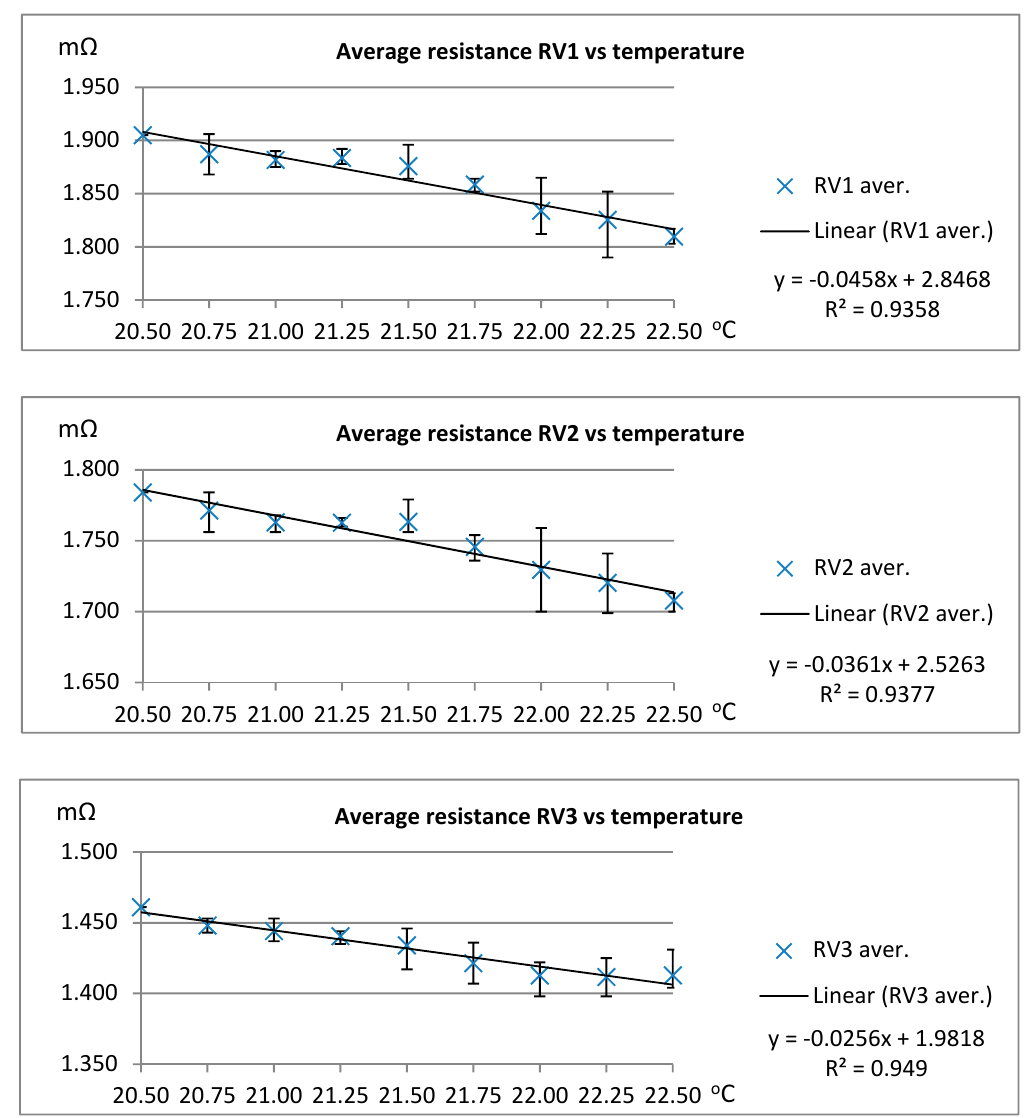
Figure 9. Average resistance of RV1 to RV3 vs. temperature .